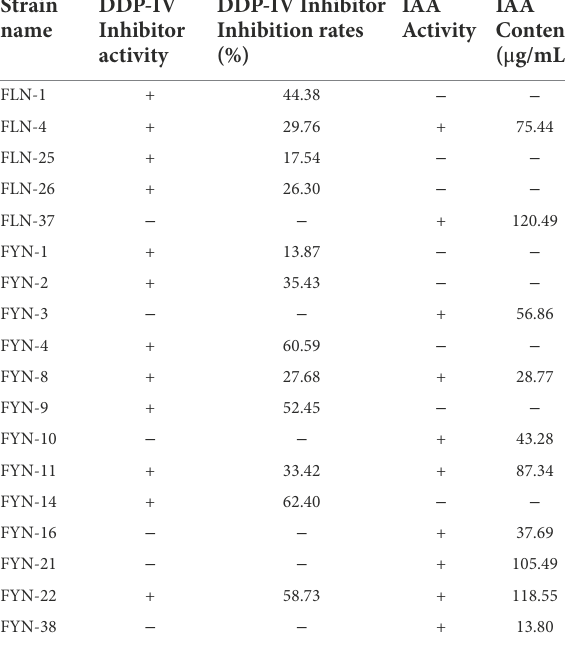
TABLE 2 Detection of FYN-22 strain with DDP-IV-inhibitory activity and IAA activity. ‘+’ denotes presence of the ability; ‘ − ’ denotes absence of the